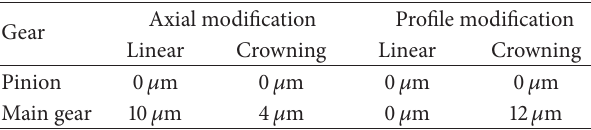
Table 2: Gear parameters of one-level reducer via modification parameters.